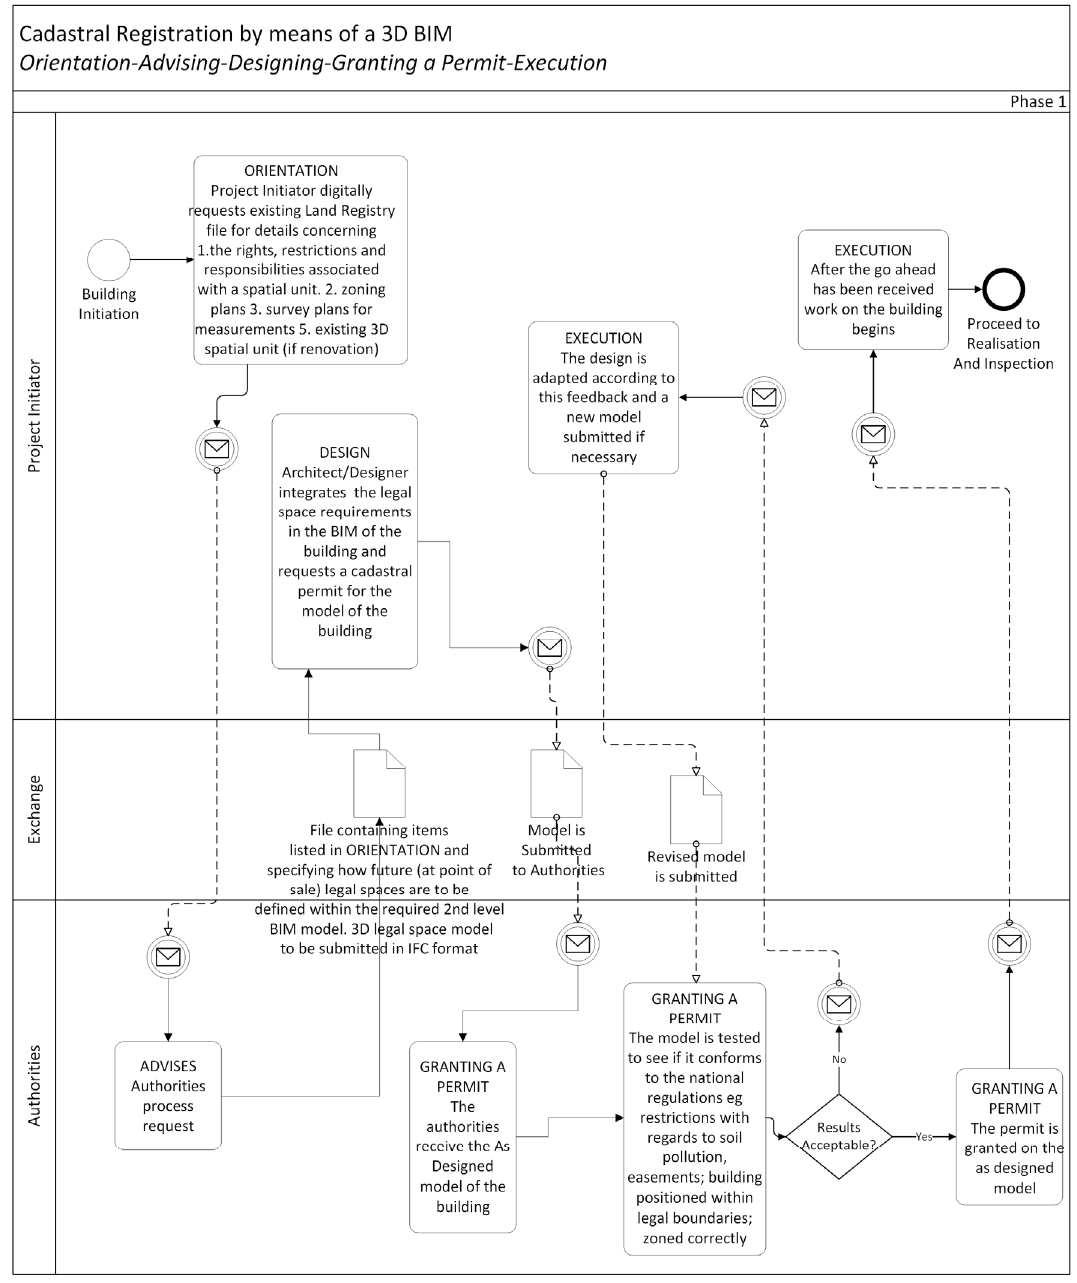
Figure 2. Information Delivery Manual (IDM) Workflow: Cadastral Registration by means of a 3D BIM Phase